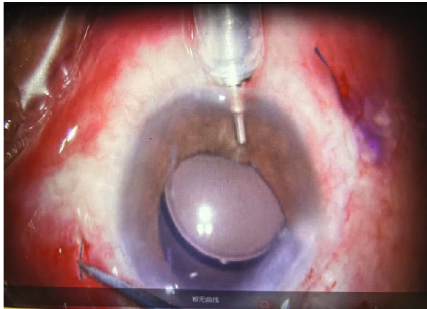
Figure 6: The haptics of the three-piece intraocular lens was derived extramurally from the sclera with a 26 G double needle.